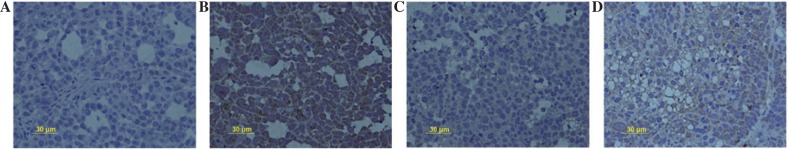
SN50 inhibits matrix metalloproteinase-9 (MMP-9) protein expression. Pathological changes in the SGC7901 tumor cells in (A) the model control and (B–D) experimental groups. (B) 5, (C) 10 and (D) 15 days after treatment with SN50. Hematoxylin and eosin (HE) staining; magnification, x200.